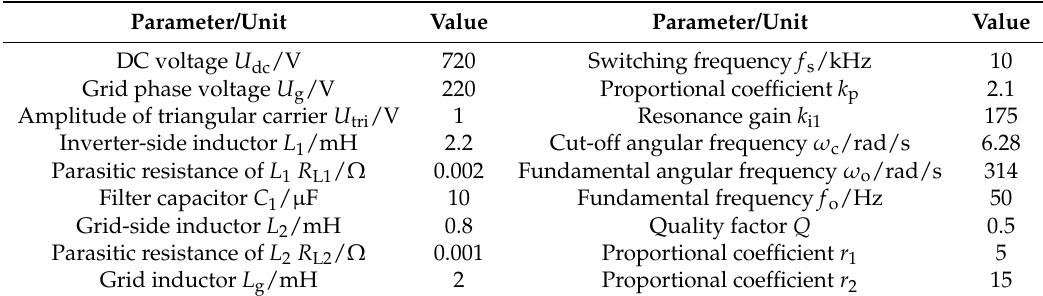
Table 2. System parameters.